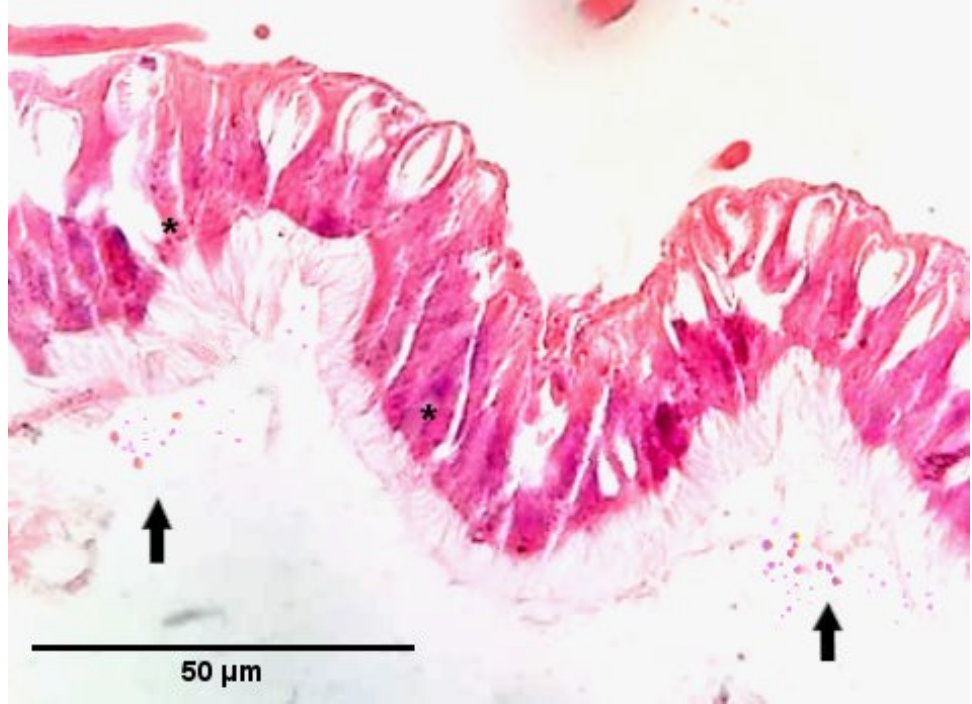
Figure 4. Histological image of the midgut of the greater wax moth larvae. Cylindrical epithelial cells with microvilli (asterisks) infected with 10 6 Nosema spores (infection with mixed Nosema spores ( N. apis and N. ceranae ), 12 days post-infection). Among the epithelial cells, goblet cells with a normal structure are also seen. There are also mature Nosema spores (arrows) in the lumen. Hematoxylin-eosin staining. Bee The mRNA expression level of the PO gene was determined 6, 9 and 12 days after experimental infection. PO-specific amplification was confirmed for the primers of PO in the melting curve analysis and through the Tm values. mRNA levels of PO increased sig- nificantly at the mixed infection of N. apis and N. ceranae in A. mellifera compared to control or single- Nosema -infected bees on the 6th day post-infection (Kruskal–Wallis, p < 0.05; Fig- ure 5A). Besides, the expression of this gene increased in all Nosema infection groups com- pared to the control group at 9 and 12 days post-infection (Kruskal–Wallis, p > 0.05; Figure 5B,C). In G. mellonella , there was no increase in mRNA levels of PO in both single and mixed N. apis and N. ceranae infection groups compared to the control group at 6, 9 and 12 days post-infection, and no statistical difference was found among all experimental groups (Kruskal–Wallis, p > 0.05; Figure 5D–F). No decrease was observed in any infection in both A. mellifera and G. mellonella compared to the control group.